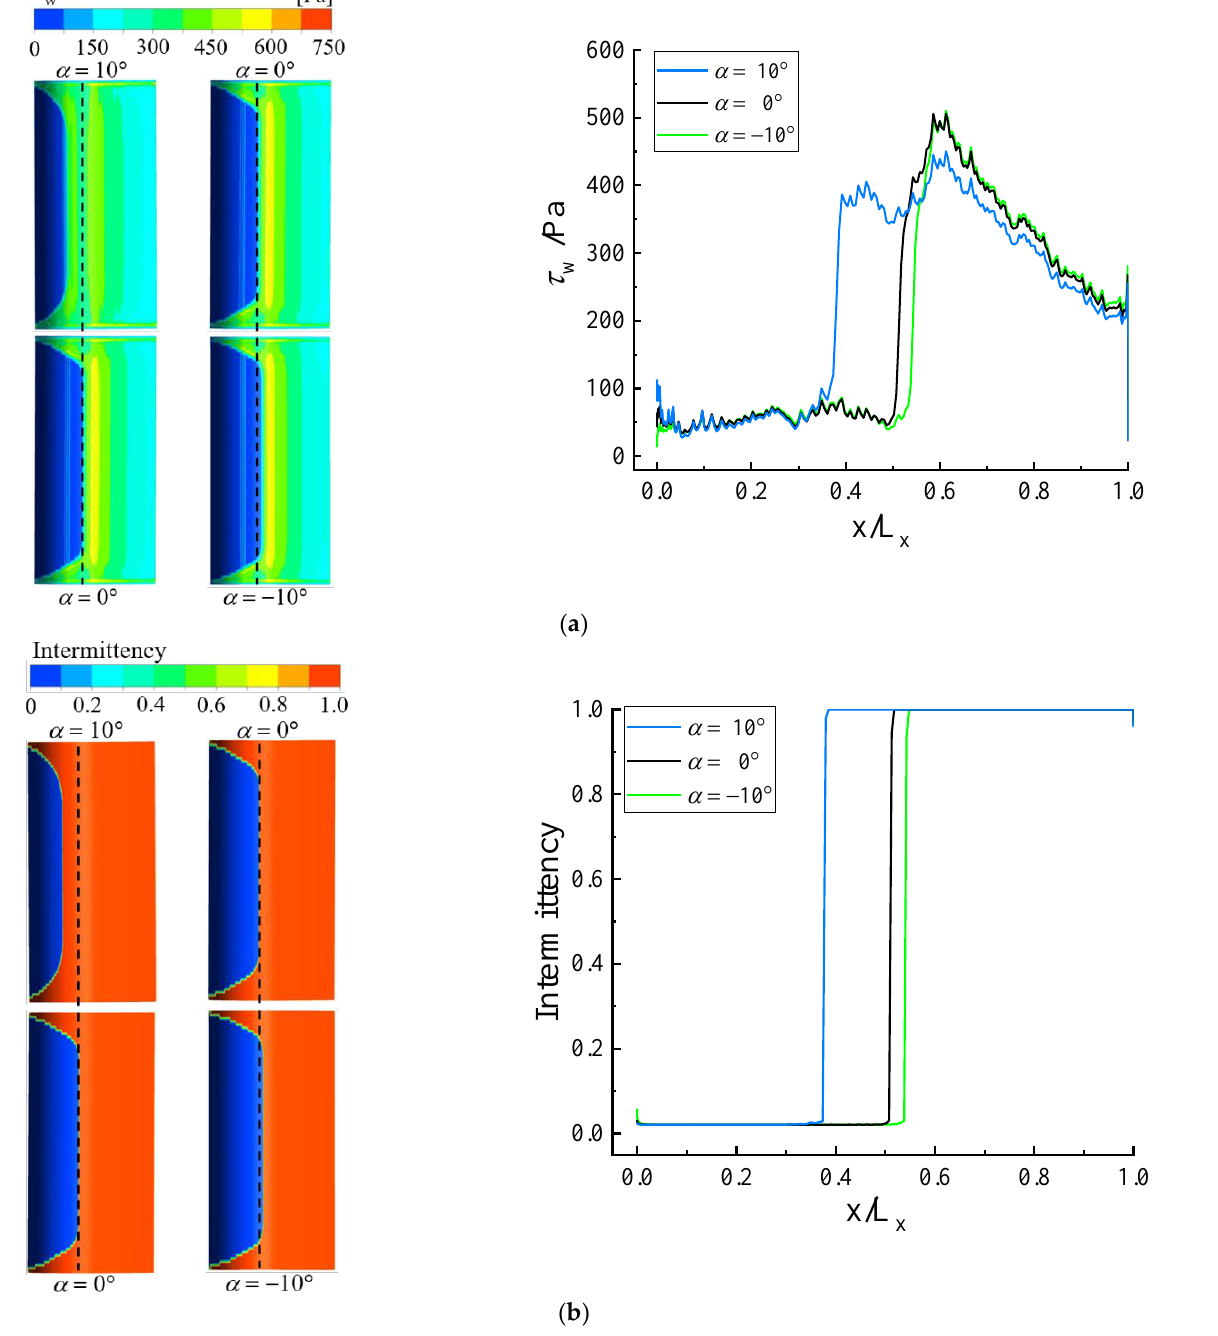
Figure 12. Intermittency and wall shear distribution of blade suction surface. ( a ) Wall shear; ( b ) intermittency.